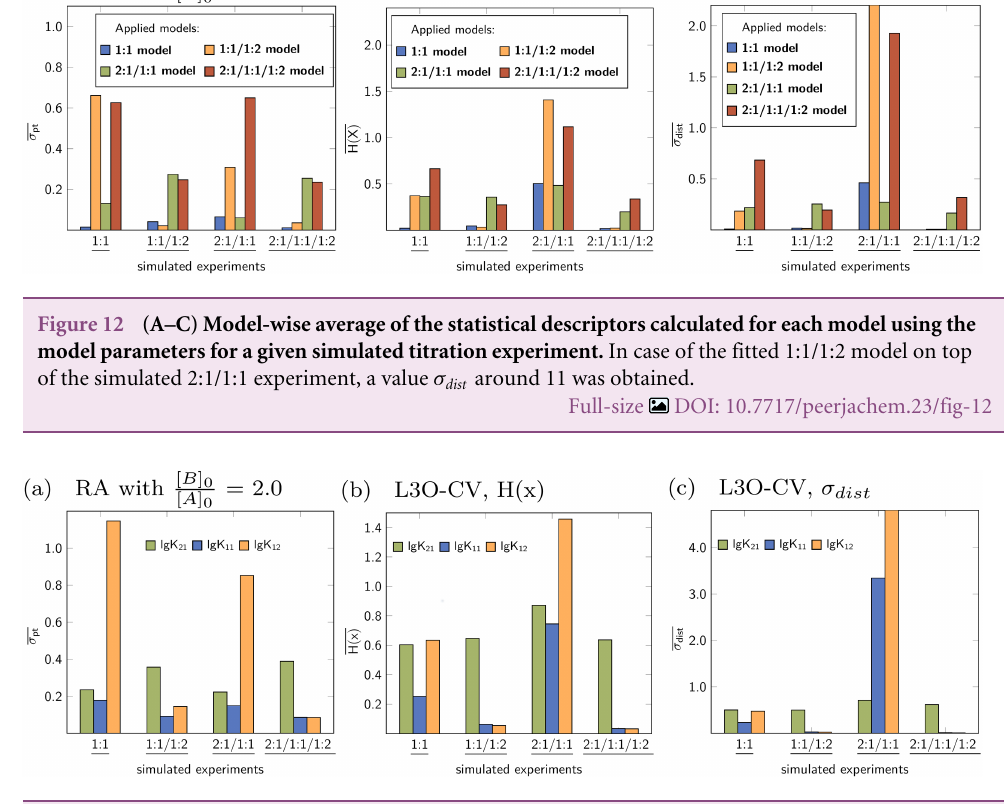
Figure 13 (A–C) Parameter-wise average of the statistical descriptors calculated for each parameter of all models applied to a given simulated titration